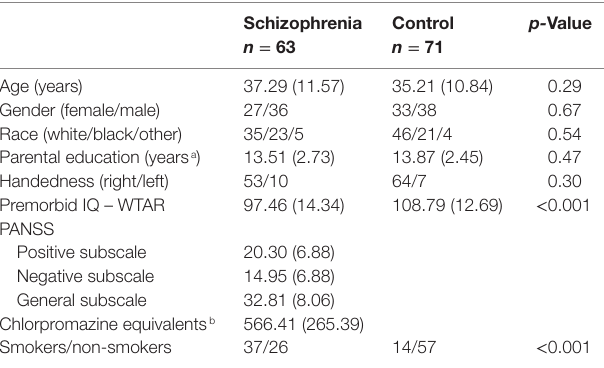
TaBle 1 | Participant demographic and clinical